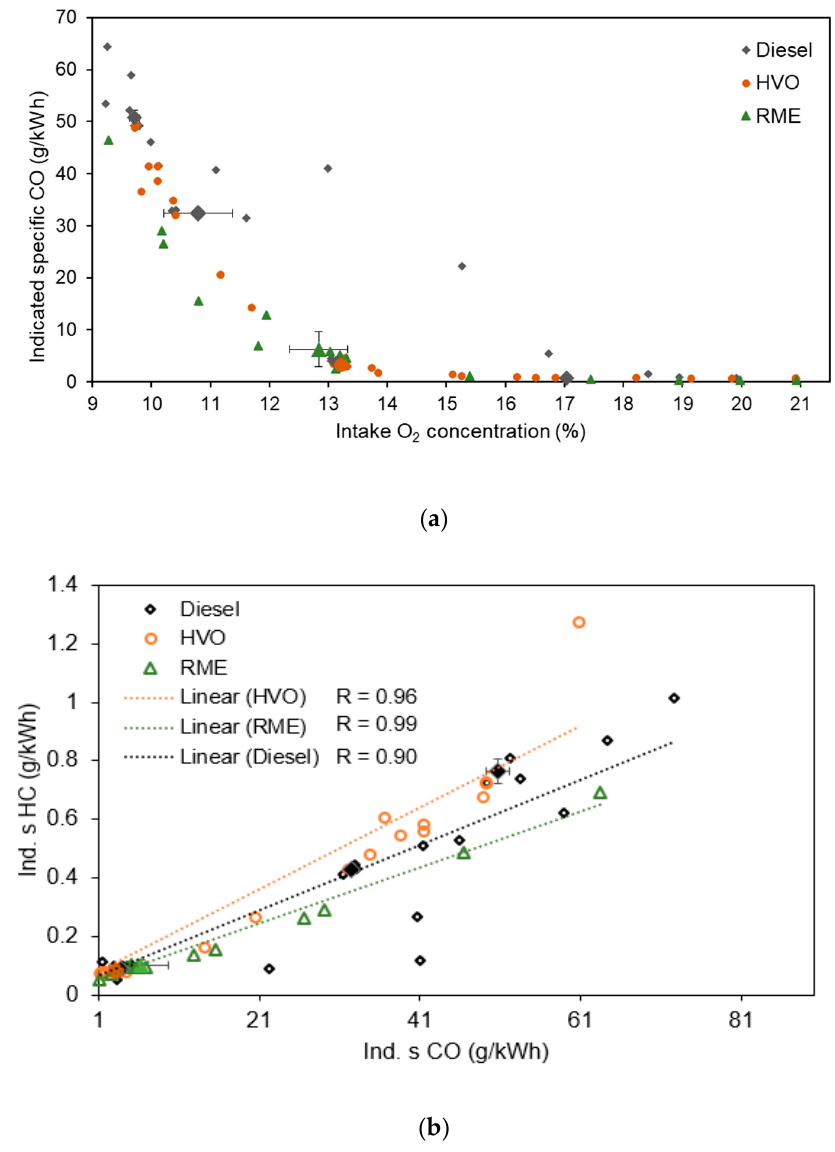
Figure A2. ( A ) The CO emissions (g/kWh) for the fuels depending on EGR (expressed as intake O 2 concentration). Markers with error bars (±1 std. dev.) represent the average emission factor of the replicates. We approximate the variability of the replicates to ±5–55% of the mean values. ( B ) The HC-CO correlation with error bars (±1 std. dev.) of the replicates.